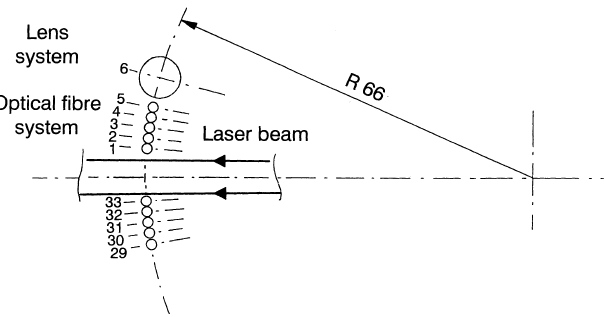
Fig. 4. Schematic diagram of the optical fibre detectors showing the laser beam, the position and numbering of the elements (see Table 3 for the corresponding values of the polar